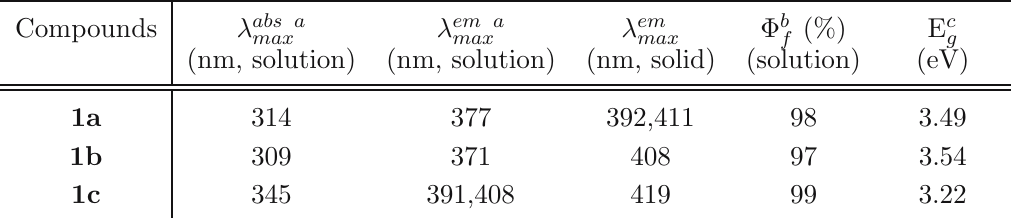
Table 2 The optical properties of 1a-c